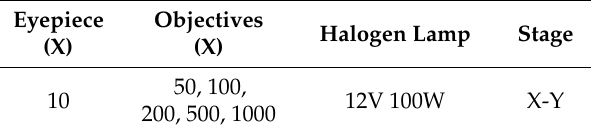
Table 5. Optical microscope BX53M